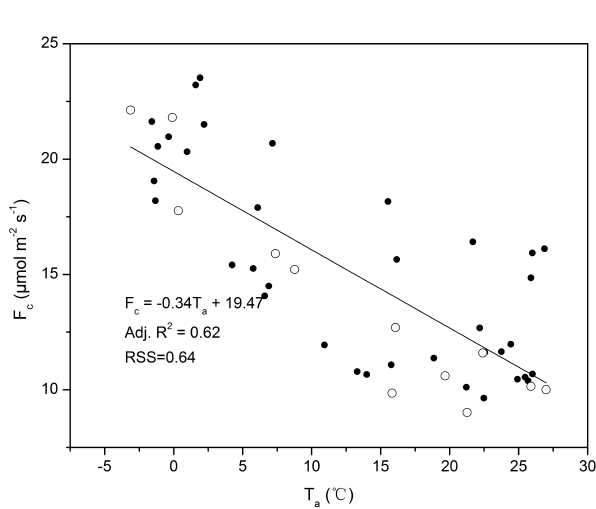
Fig. 10. The relationship between monthly average F c and air tem- perature ( T a ). The open circles represent the cases in